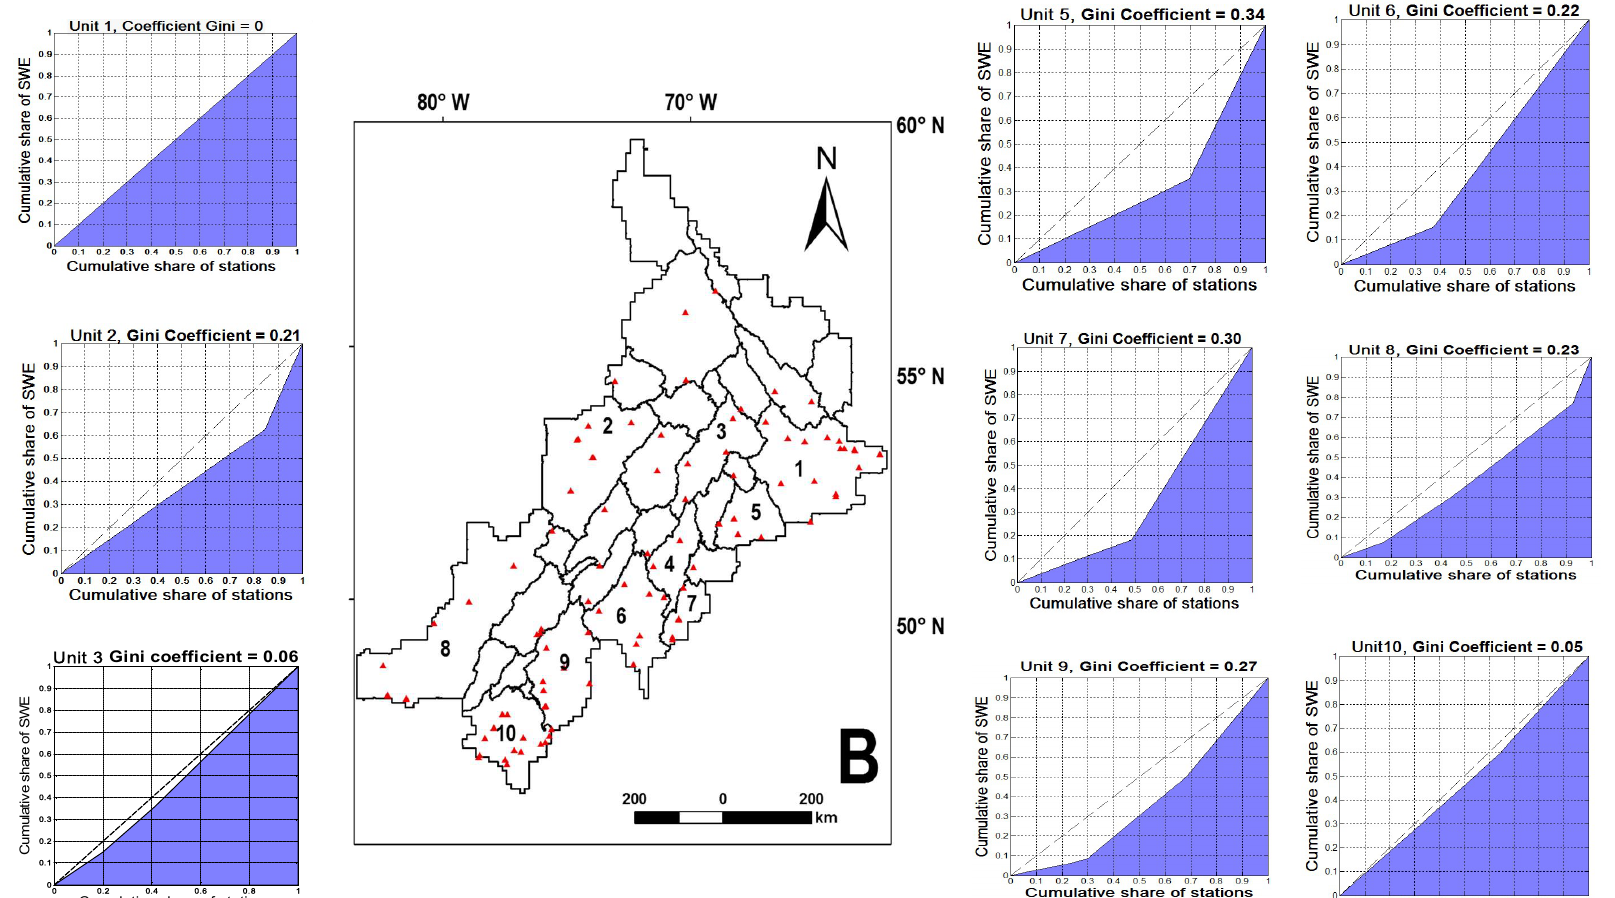
Figure 7. Lorenz curves and values of the spatial distribution unevenness of stations in the units of zone B, at the local scale.